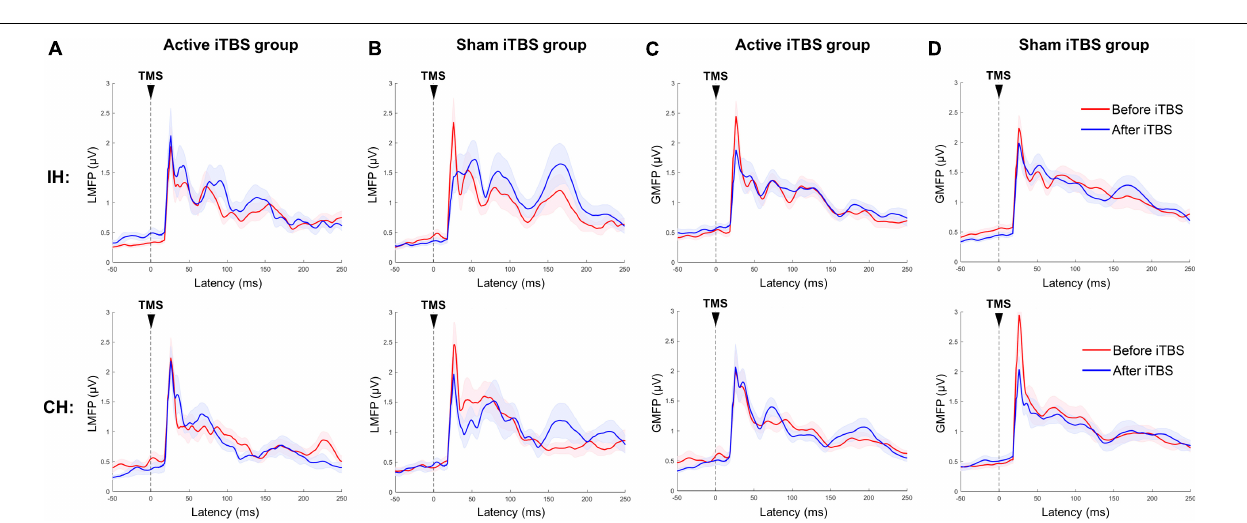
FIGURE 1 | TMS-evoked EEG potentials in a representative subject. Top row: The gray curves represent TEP in each channel, and the red bold curves represent the averaged TEP in the channels surrounding the stimulated motor cortex (C4). Bottom row: Topographic plots of the TMS-evoked responses at 30, 45, 60, 100, and 180 ms post-TMS.